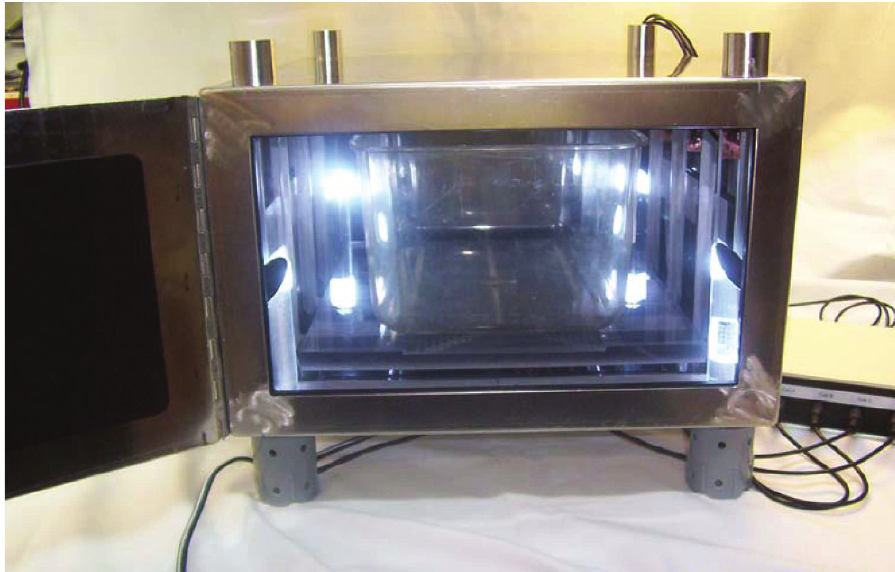
Figure 3 - Diagram of the mu-metal box with a pulsed electromagnetic field generator at 100 Hz. Four vertical light pipes were mounted within the enclosure (one in each corner port). These acrylic rods are removable. Light was supplied by four LED sources that fit under the lower ports. The four rectangular coils were mounted inside the mu-metal box in a Merritt-like